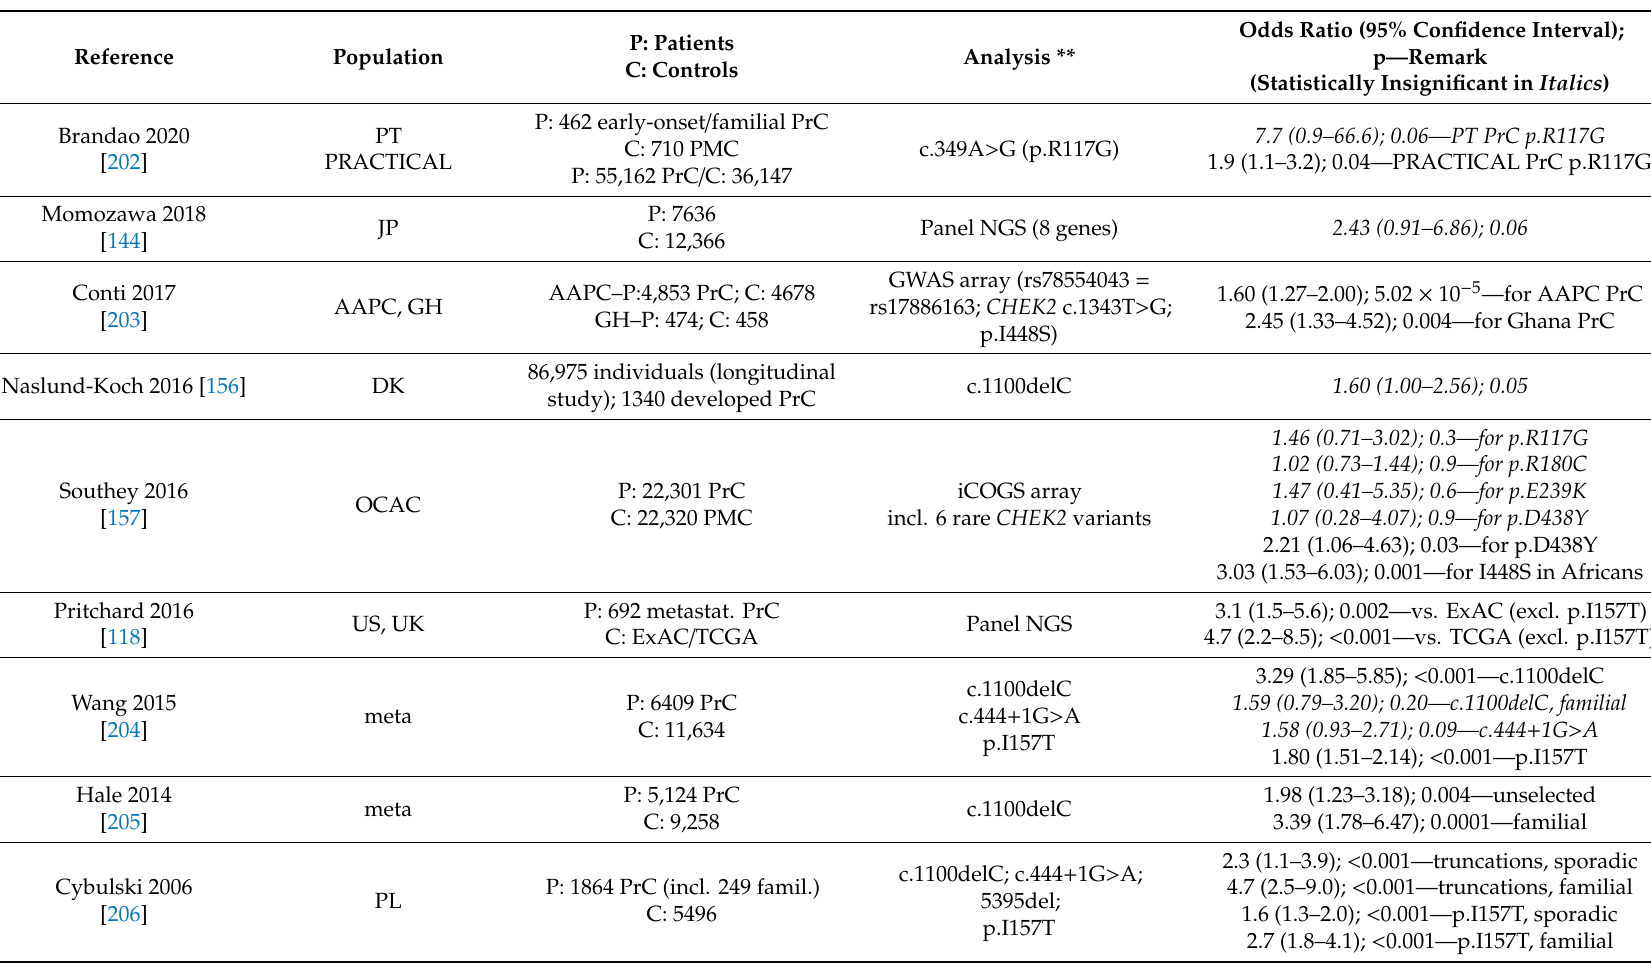
Table 2. Analyses of the entire CHEK2 coding sequence (separately or as part of panel NGS) or analyses of specific variant(s) in prostate cancer (PrC)